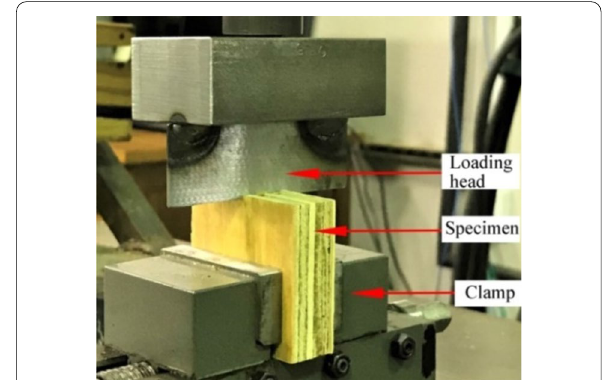
Fig. 6 Test setup for evaluating the load–deformation behavior of single staple legs bearing in half-hole pine plywood test